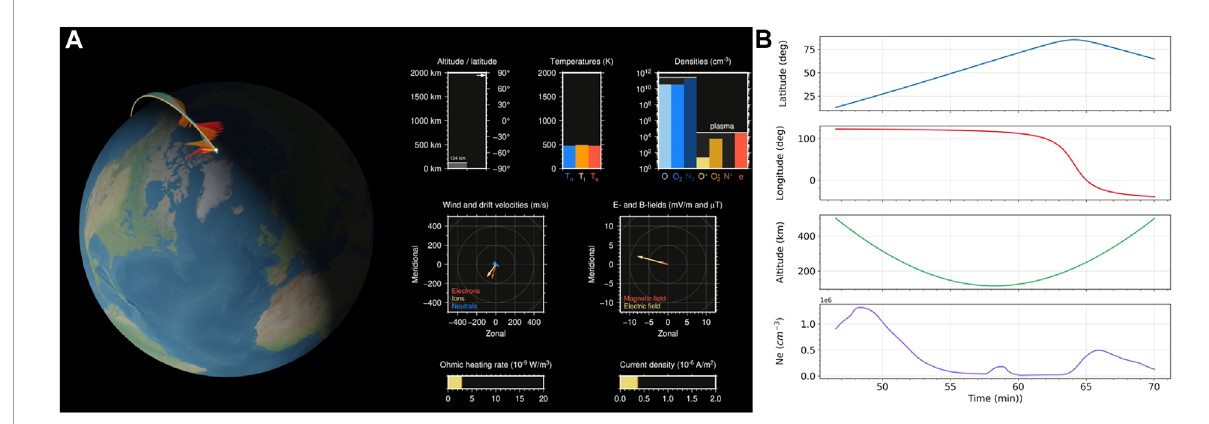
FIGURE 6 Example of the along-orbit interpolation of various primary geophysical observables: The (A) (globe) shows sample orbit of Daedalus, with vectors of neutral winds and ion drifts plotted along the orbit; the middle panels show a “dashboard” of instantaneous measurements, obtained through the along-orbit interpolation; the (B) show spacecraft latitude, longitude, altitude, and along-orbit time series of electron density.